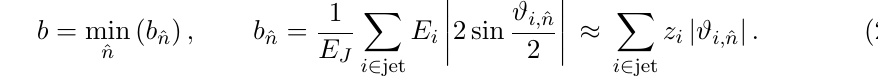
Figure 5 . Parton shower picture for the broadening axis. Here all momentum fractions are relative to the parton initiating the jet. When the branch along which the axis lies (green) splits, the energy fractions z L and z R of the left (red) and right (blue) a(cid:11)ect which daughter (black) gets the axis. scalar sum of transverse momenta in the jet